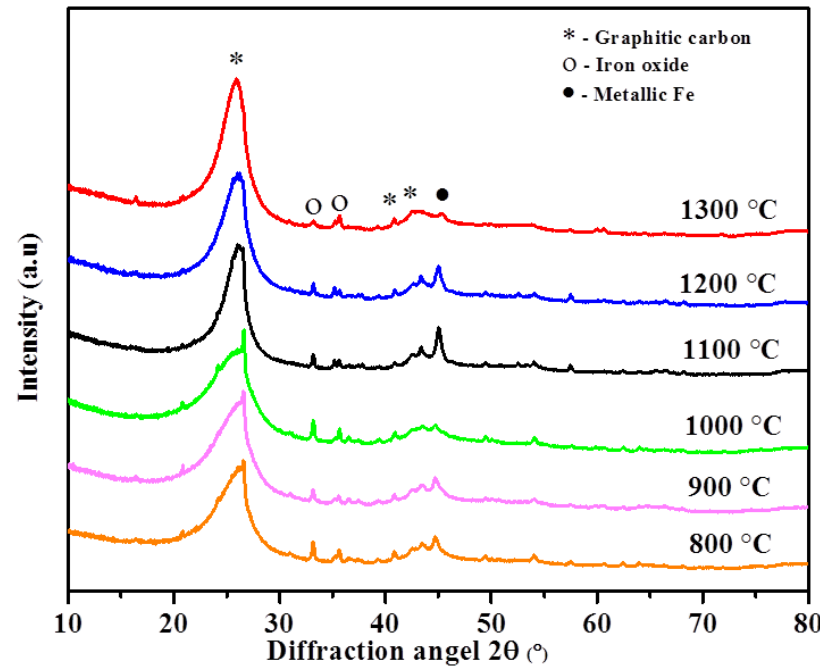
Figure 2. X-ray diffraction patterns of catalyst-loaded graphitized samples at different temperatures. The catalyst-loaded graphitized samples at 1300 °C represented an interlayer space (d 002 ) and g-factor value of 0.3357 nm and 96.5%, respectively, which were higher than other temperatures.